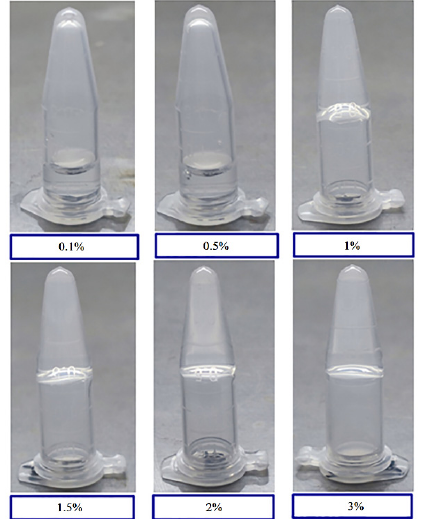
Figure 1. Tube inversion test of hydrogel formation with various gelatin concentrations. Vials containing 0.1%, 0.5%, 1%, 1.5%, 2%, and 3% ( w/v ) gelatin were subjected to a temperature of 4 °C containing 0.1%, 0.5%, 1%, 1.5%, 2%, and 3% ( w / v ) gelatin were subjected to a temperature of 4 ◦ C for 30 min and inverted for image collection. for 30 min and inverted for image